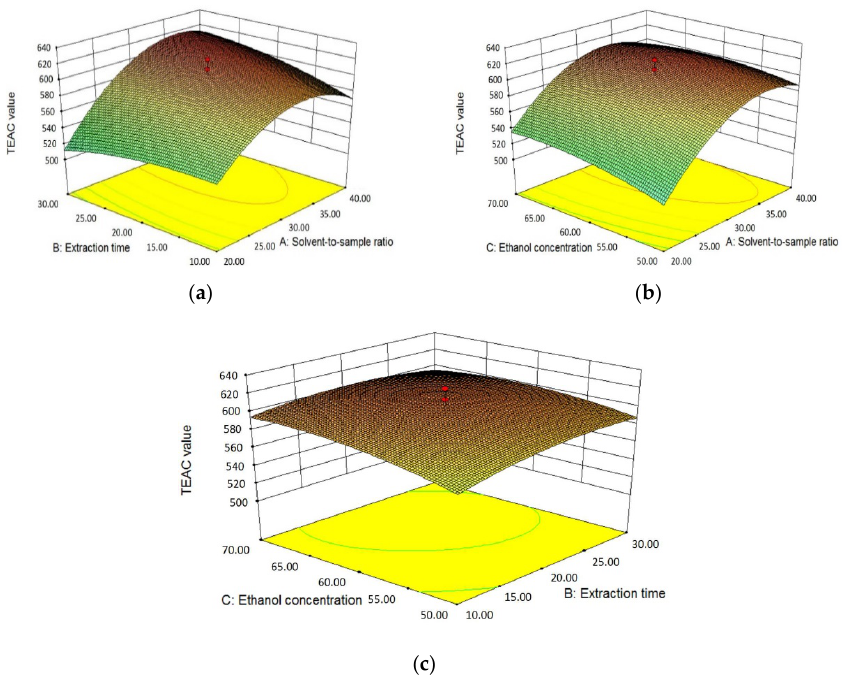
Figure 3. The three-dimensional response surface plots for the effects of solvent-to-sample ratio/extraction time ( a ); solvent-to-sample ratio/ethanol concentration ( b ); and ethanol time ( a ); solvent-to-sample ratio / ethanol concentration ( b ); and ethanol concentration / extraction time ( c ) on concentration/extraction time ( c ) on the TEAC values. the TEAC